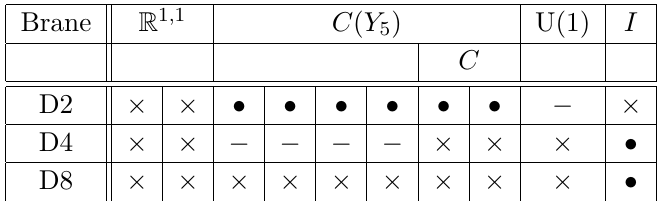
Table 1 . The brane configuration arising from our setup. The D2-branes are located at the tip of the cone over Y 5 , smeared over the circle and lie along the line interval. The D4-branes wrap a two-cycle in Y 5 , denoted by C in the table, along with the circle and are located at the special points of the line interval. Finally the D8-branes are located at the distinguished points of the line